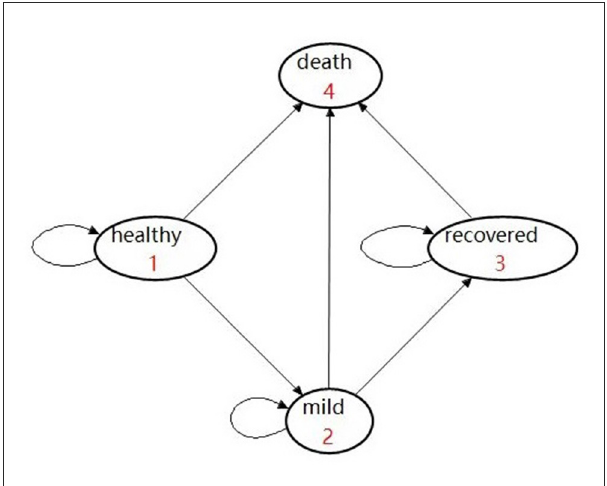
FIGURE2 Markov health states showing an “effectively vaccinated” arm.